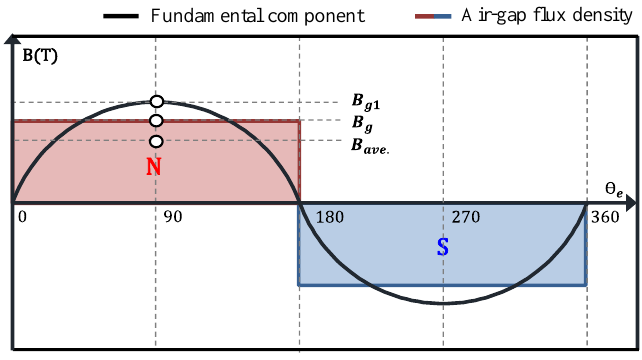
Figure 7. Air-gap flux density distribution and its fundamental component.